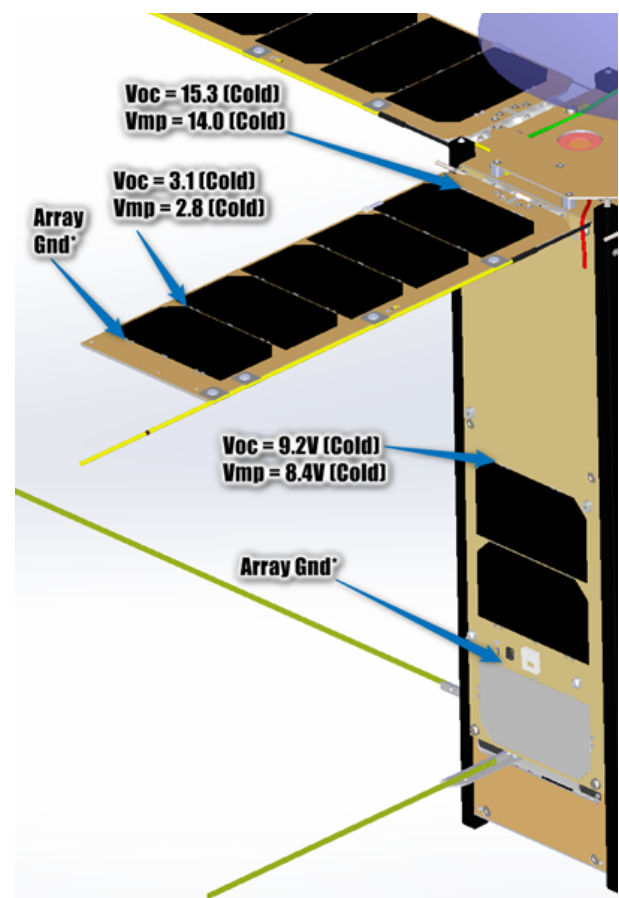
Figure 5. Location of the solar cells and interconnects on the solar panels (credit AAC Clyde Space